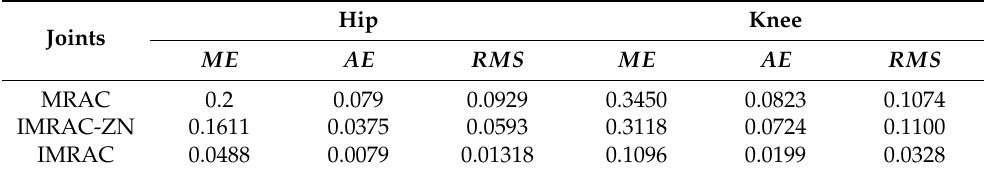
Table 6. Statistical analysis